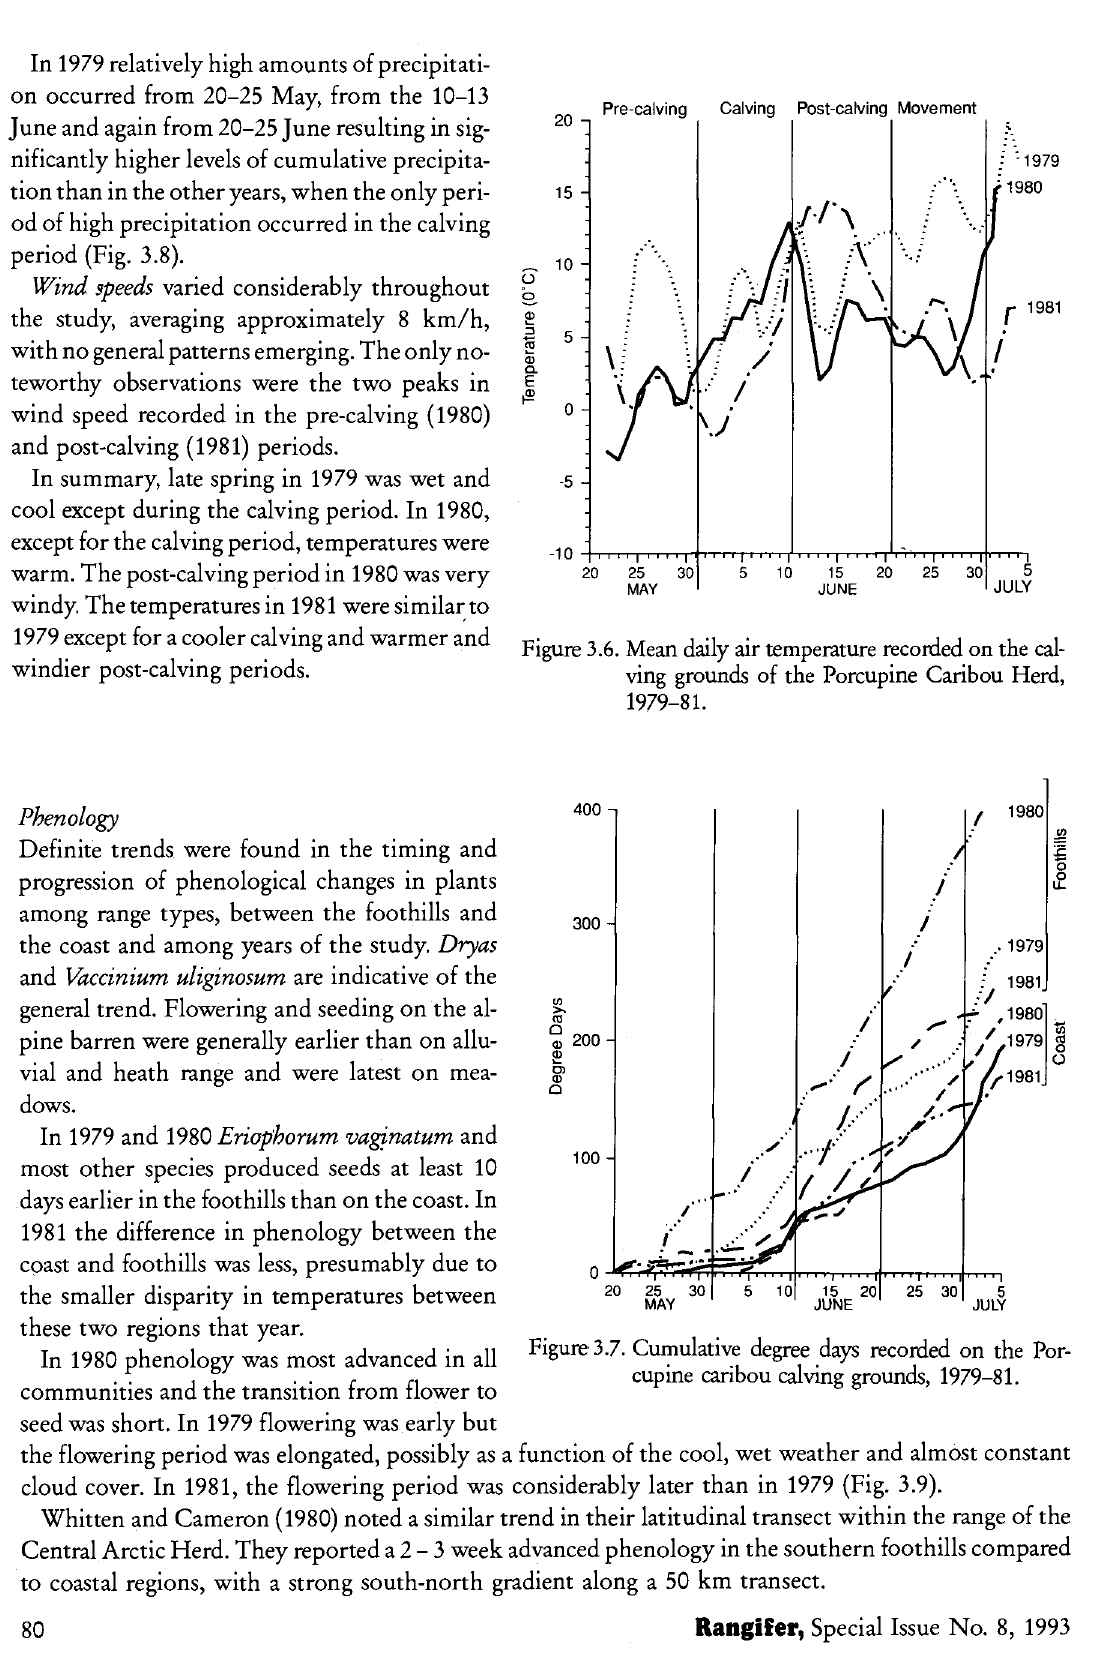
Figure 3.7. Cumulative degree days recorded on the Por cupine caribou calving grounds,